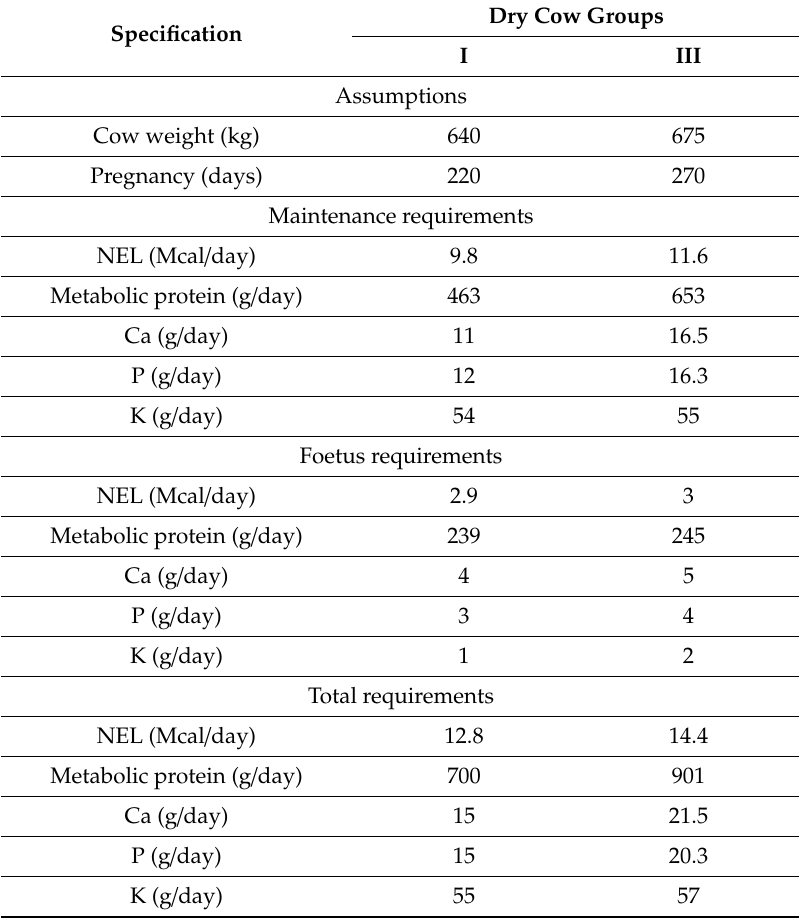
Table 1. Daily requirements of the